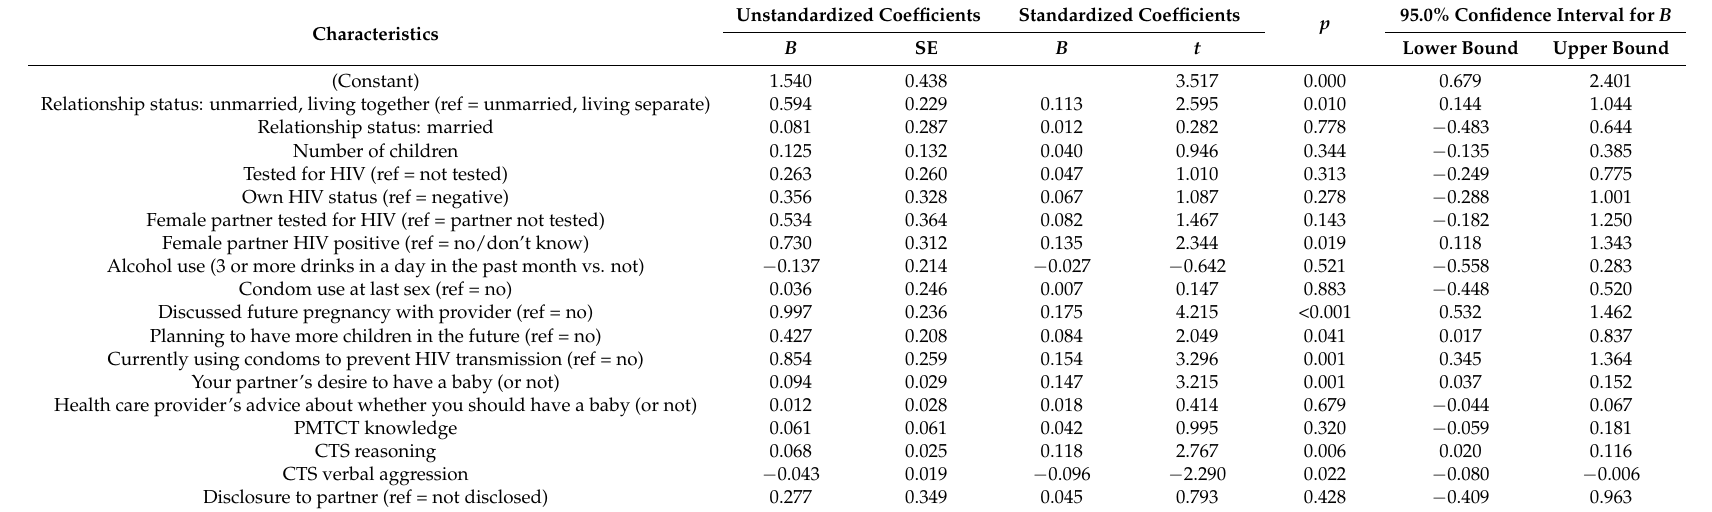
Table 3. Results of linear-regression model predicting MPI ( N = 454).